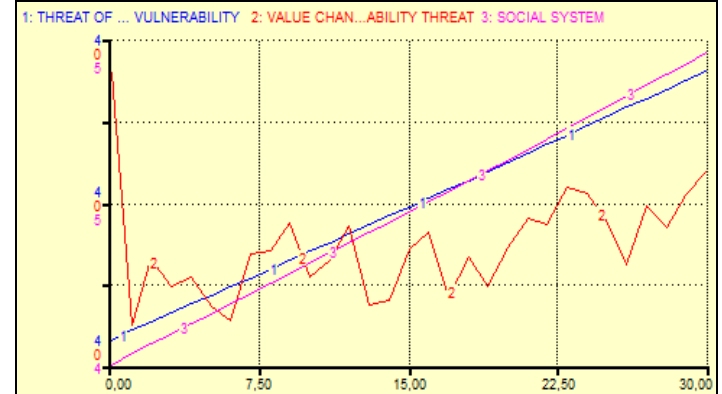
Fig. 7. The Influence of Islamic State Development on Social